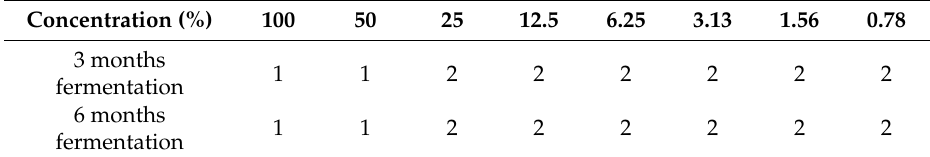
Table 2. Enterococcus faecalis growth at different concentrations of papaya eco-enzyme (P-EE).